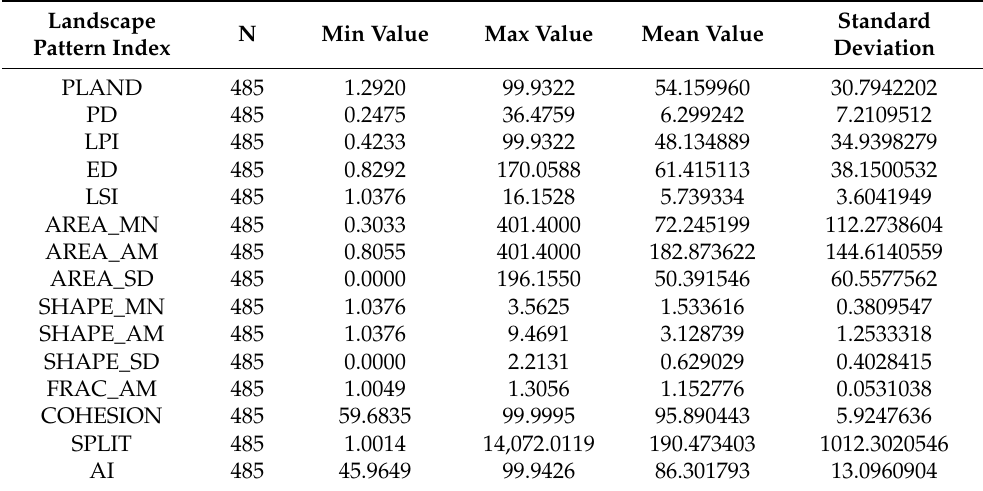
Table 3. Statistical analysis results of the Landscape Pattern